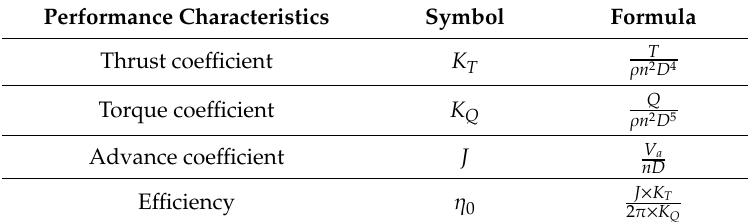
Table 3. Non-dimensional performance and operational parameters for